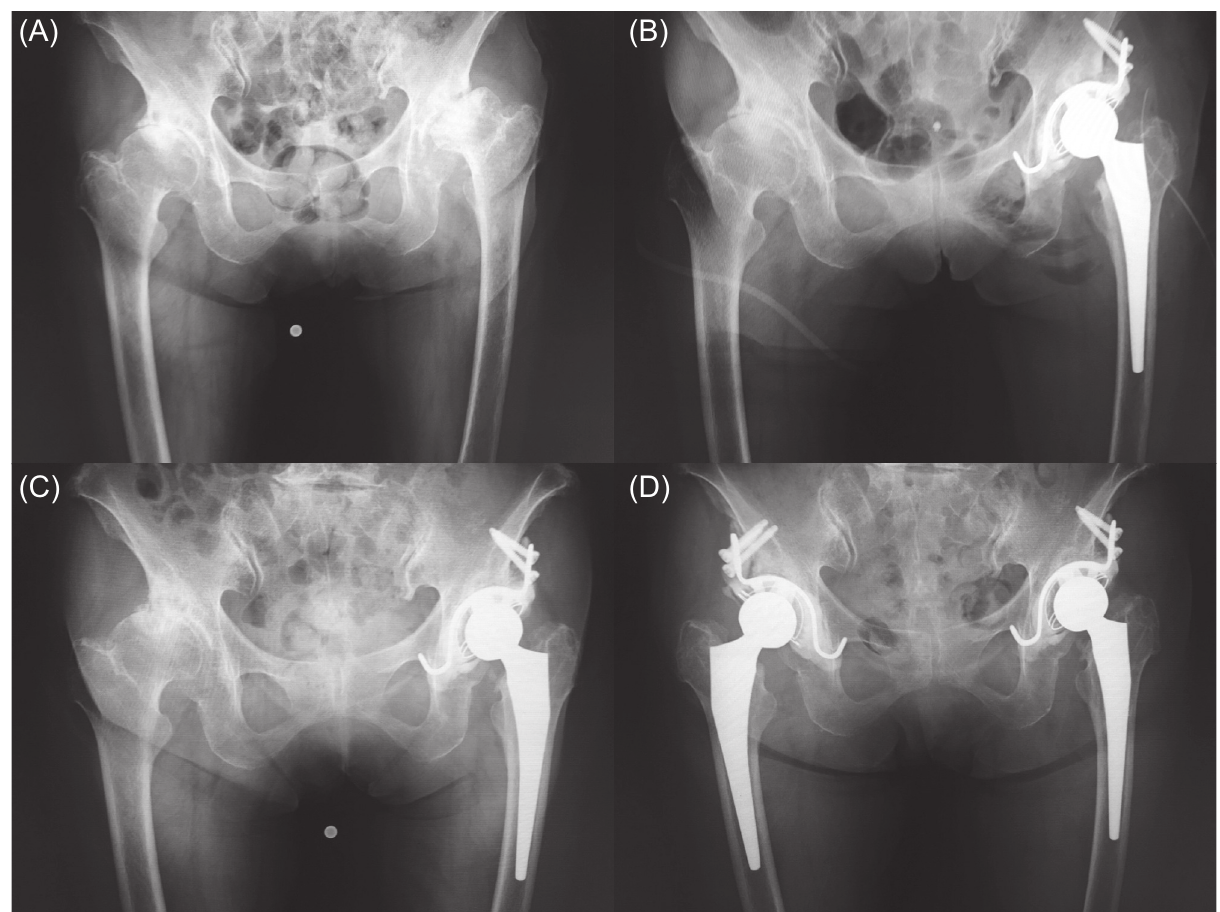
Figure 1. (A) Osteoarthritis of the bilateral hip, (B) immediate post-operative x-ray of the left hip, (C) 12 months after the operation. Right hip required THA, (D) there is no sign of implant loosening at 12 month after right THA, 24 months after left